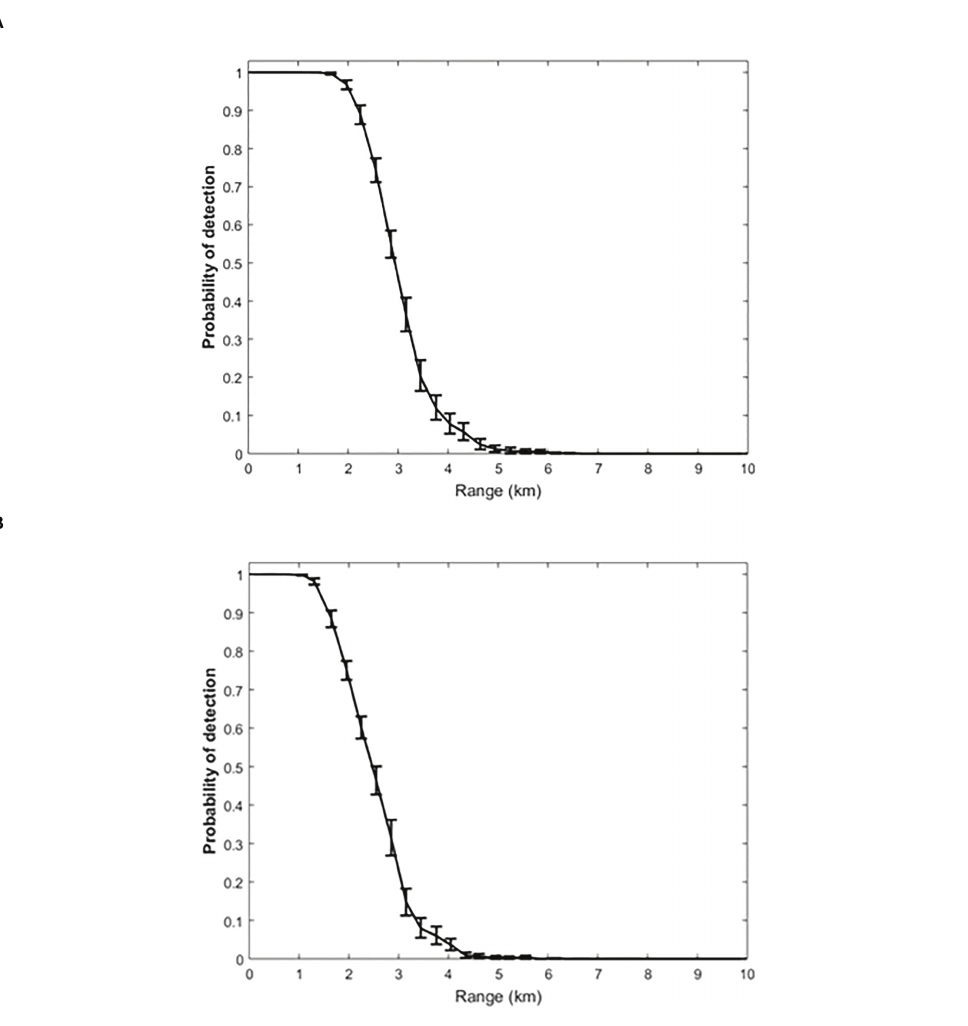
FIGURE 5 Estimated probability of detection with error bars as a function of range for (A) Cuvier ’ s and (B) Gervais' beaked whale clicks based on Monte Carlo simulation with the 2015 data